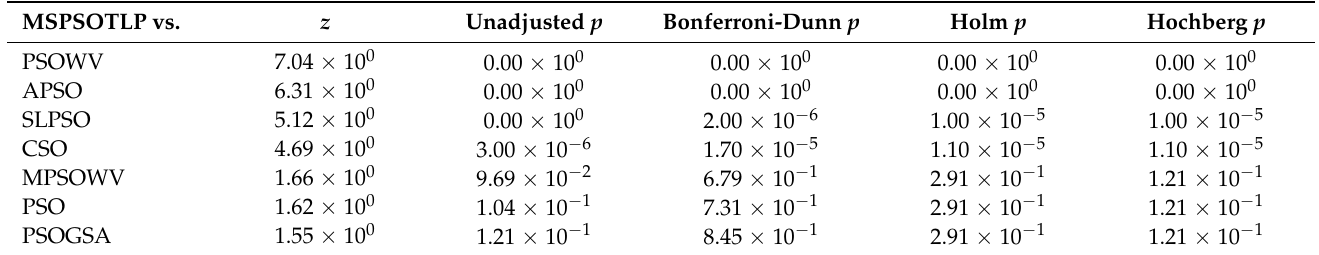
Table 17. Adjusted p values produced by trained ANN models in solving training samples through three post-hoc analysis procedures.